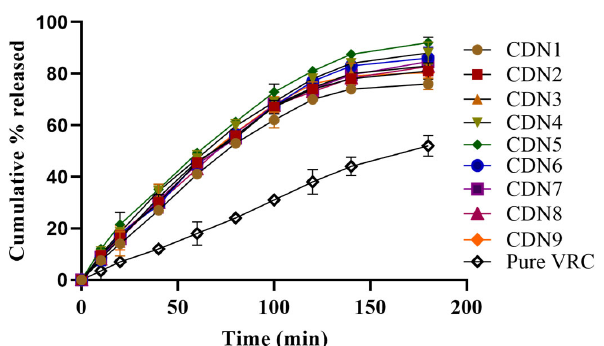
Figure 8. Effect of pH 1.2 on VRC release.